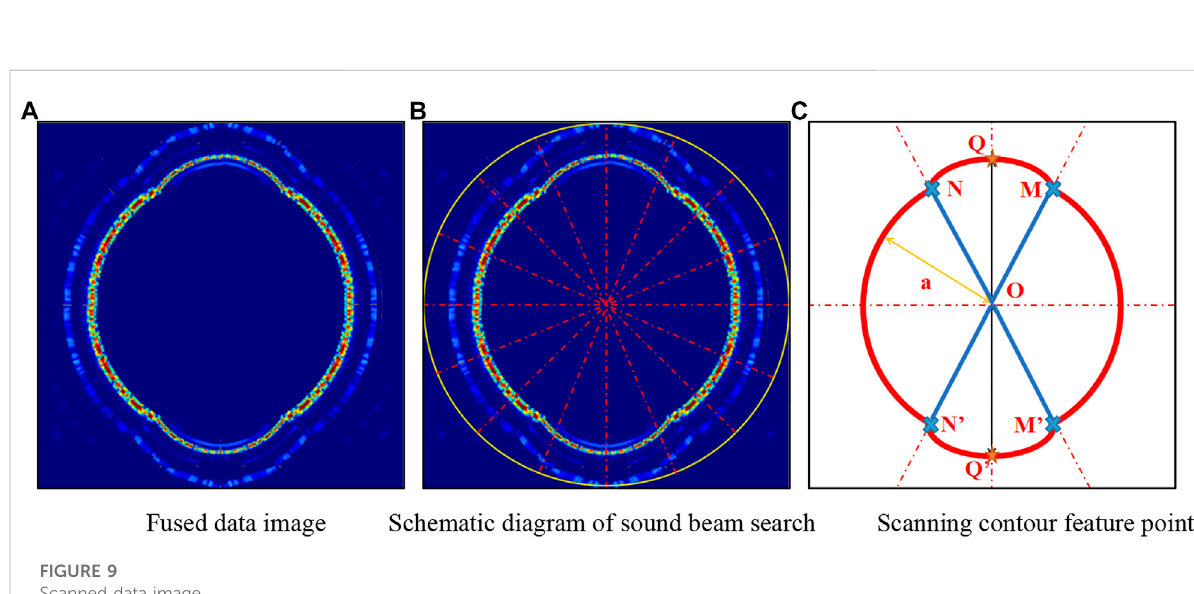
FIGURE 9 Scanned data